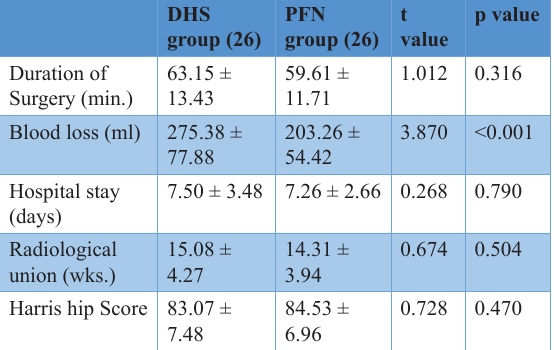
Table 2. Perioperative and follow up comparison between DHS and PFN group.